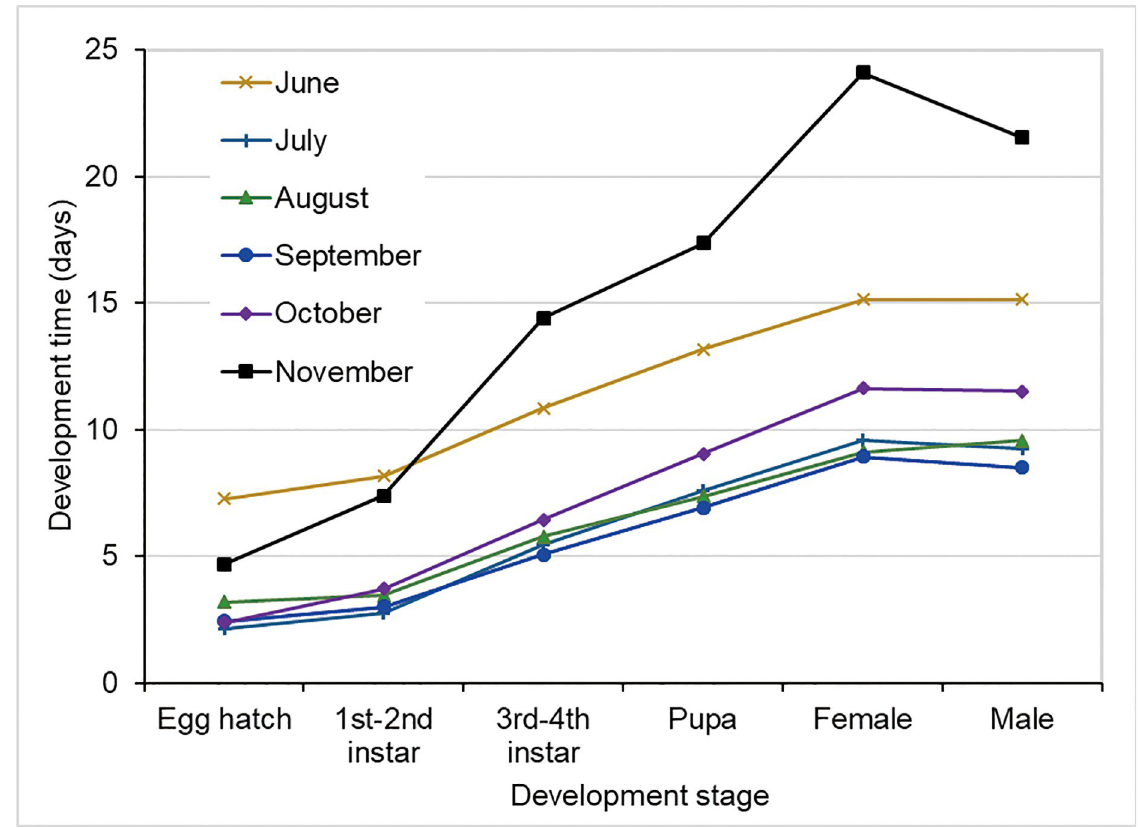
Fig 6. Kaplan-Meier survival curve of Ae . albopictus larvae in different months. June-July experiments were conducted in semi-natural condition and August-November experiments were conducted in semi-field condition.